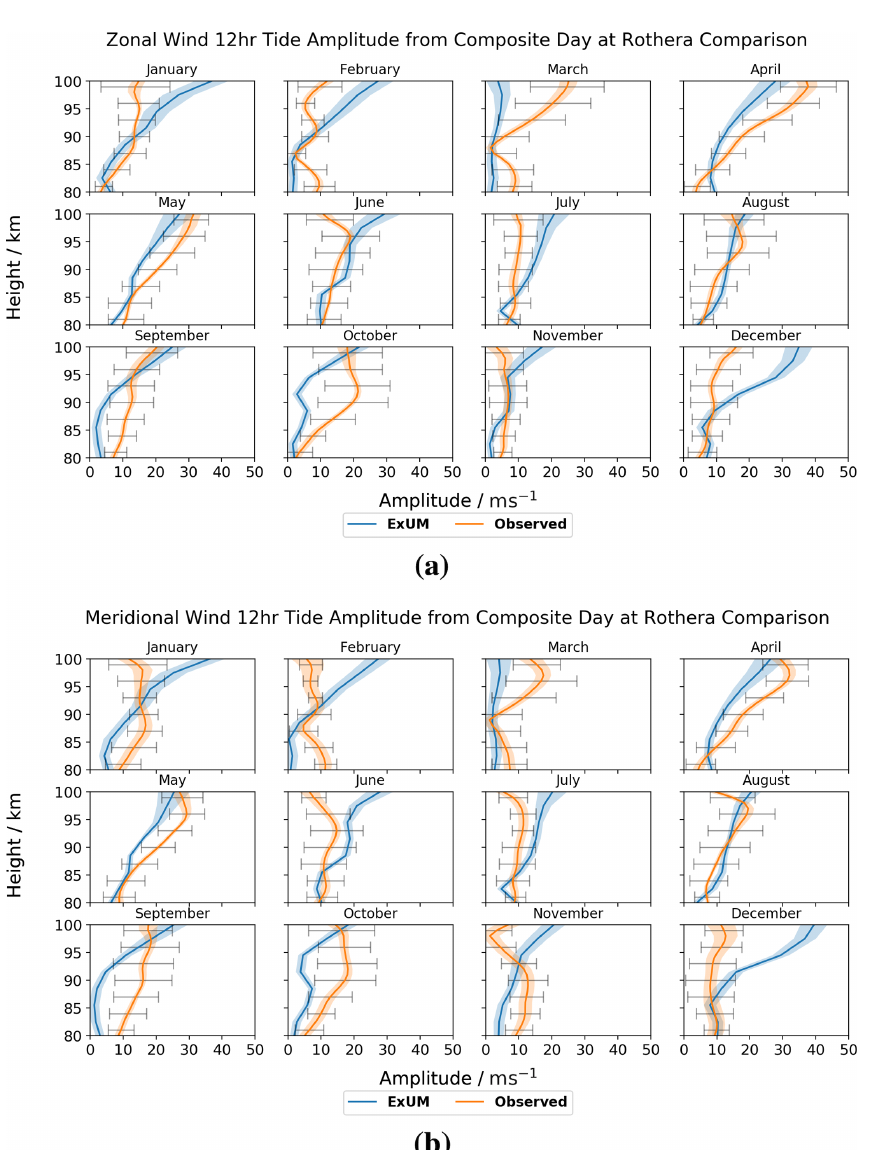
Figure 13. Amplitudes for each month as a function of height for the (a) zonal ( u ) and (b) meridional ( v ) components of the semi-diurnal tide at Rothera. The shaded regions denote the standard deviation from the curve-fitting algorithm, and the black bars indicate the standard deviation from the mean of the measured amplitudes across the month. Both the amplitudes from the model (blue) and meteor radar (orange) are